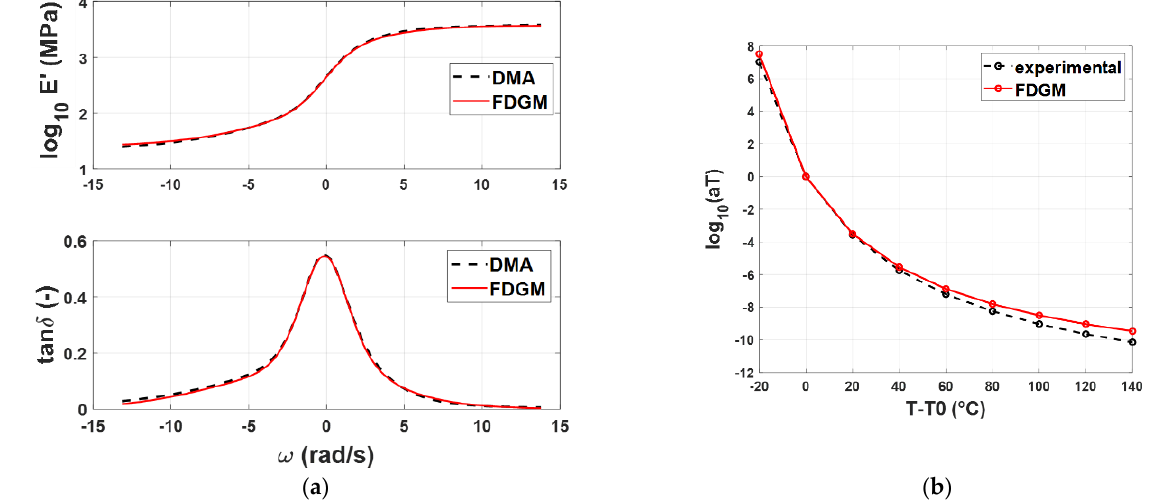
Figure 9. Compound B: Storage modulus and loss tangent ( a ), WLF law ( b ) — experimental data (dashed line) vs. FDGM model.